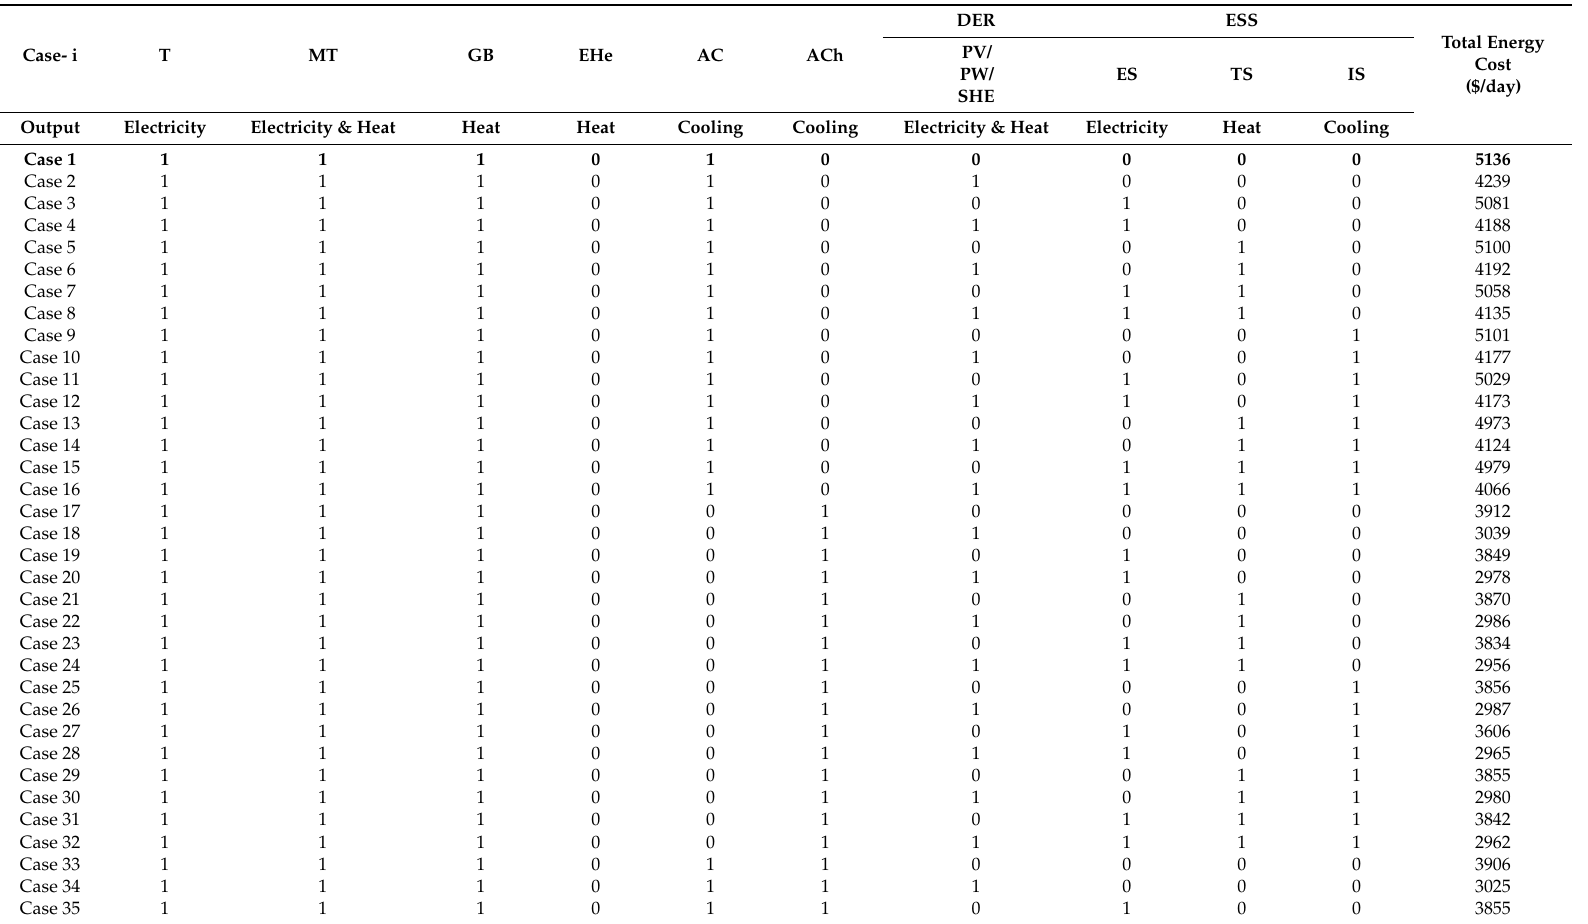
Table A1. Proposed hub operation reports in 144